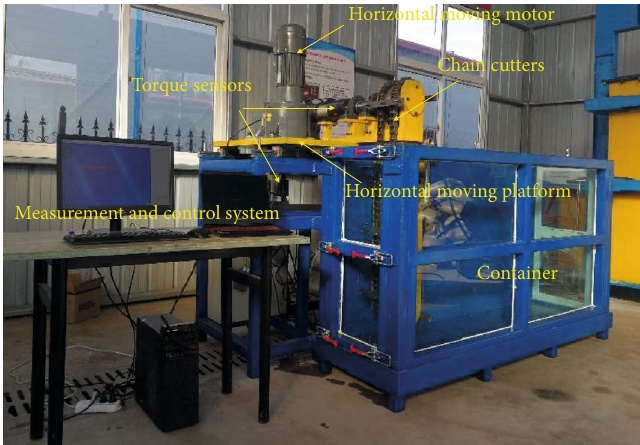
Figure 12: TRD model test device